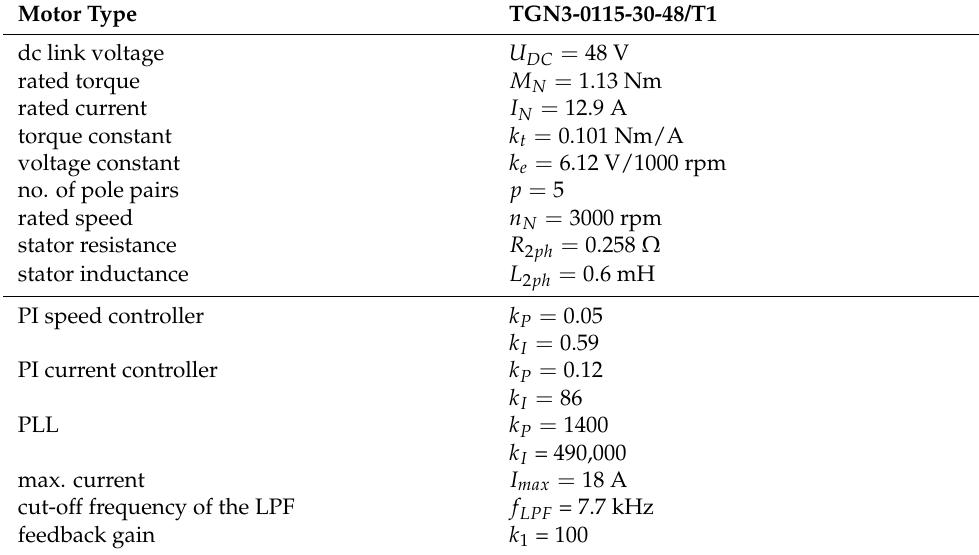
Table 1. Parameters of PMSM and